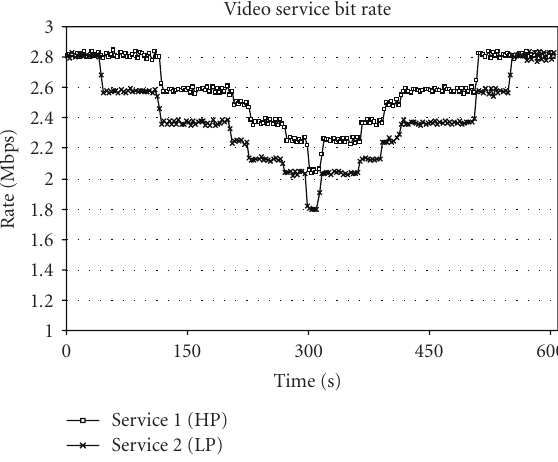
Figure 6: Variation of Probe Receiver C/N in proportion to injected noise level.